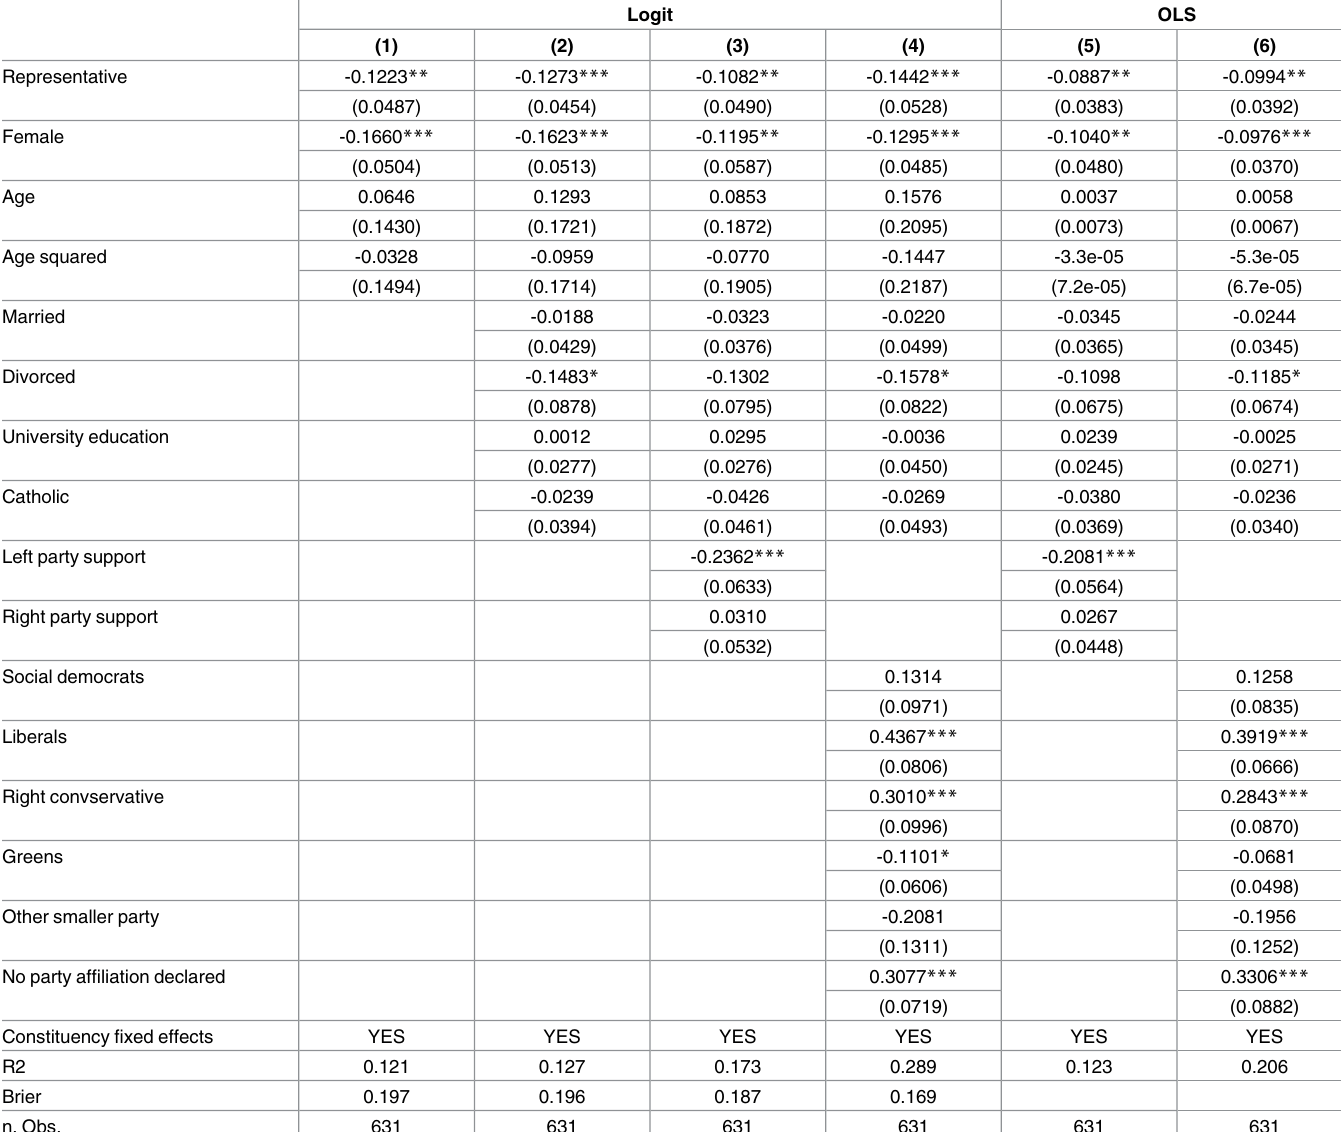
Table 1. Citizen and representative acceptance of stem cell